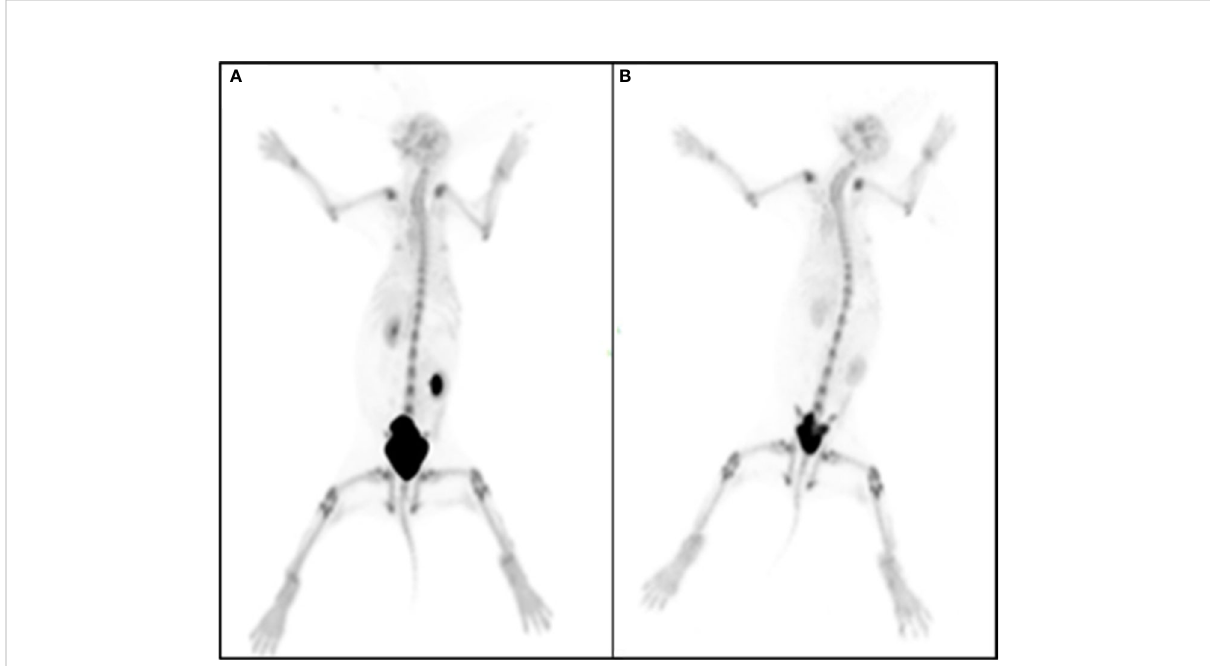
FIGURE 3 New Zealand rabbits were injected with 68 Ga-DOTA-IBA 2.0 mCi at 1 h (A) and 3 h (B) after whole body bone visualization.